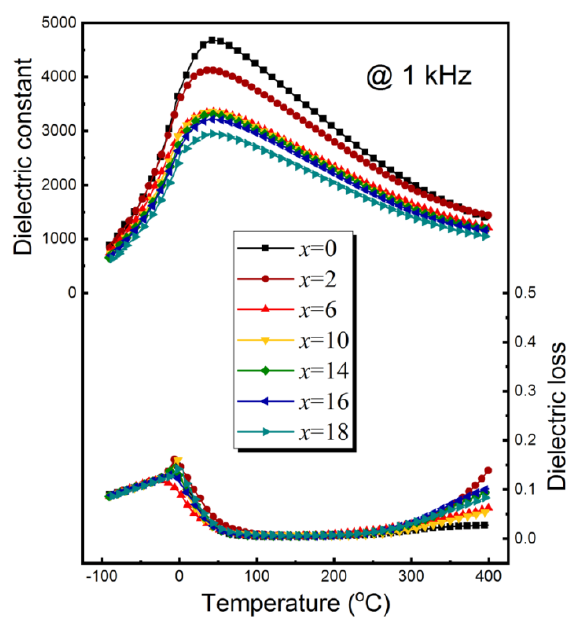
Fig. 4 Dielectric constants and loss of BS 0.5 BNT– x GS ceramic composites as a function of